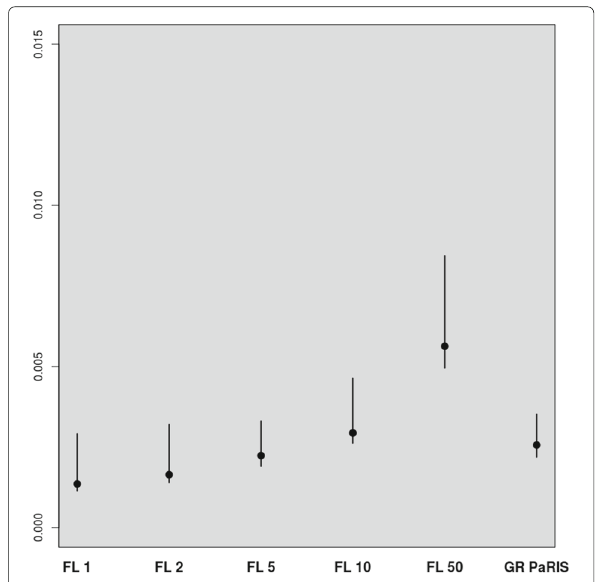
Fig. 5 SINE model - variance. Distribution of the empirical absolute coefficient of variation